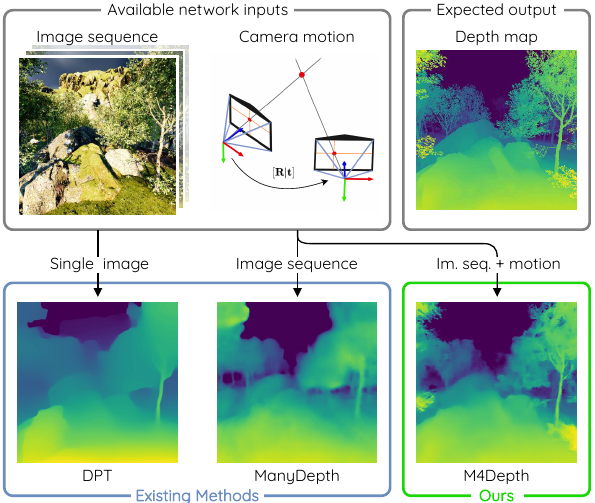
Figure 1. State-of-the-art depth estimation methods such as DPT [19,21] or ManyDepth [22] struggle to produce accurate estimates in cluttered and natural environments. Our method, called M4Depth, outperforms existing methods in these instances and generalizes well to unknown